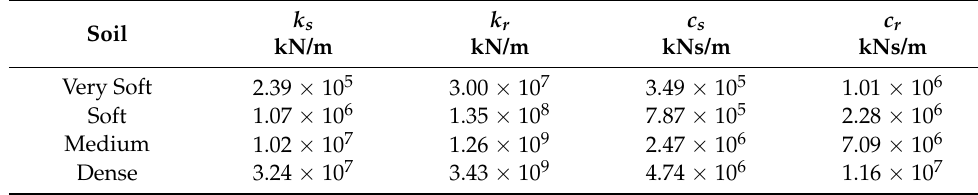
Table 2. Soil properties of the five- and ten-story